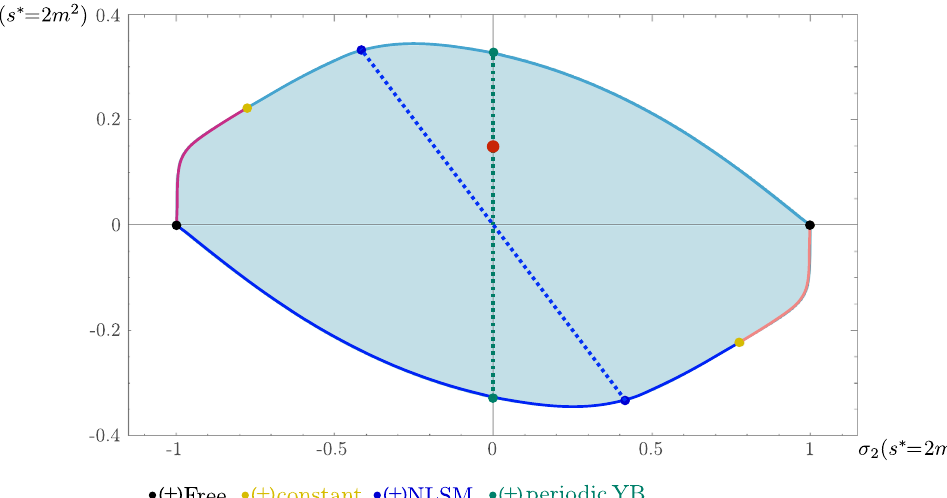
Figure 7: Allowed space of S-matrices in the plane  1 ( s ⇤ = 2) vs  2 ( s ⇤ = 2). The coloring at its Figure 10 . Allowed region in the ( (cid:27) (cid:3) ; (cid:27) (cid:3) ) plane for N = 7 (from (cid:12)gure 7 of [52]). The blue 2 1 boundary matches the convention in table 1. We have also marked the points corresponding to dashed line marks the section (5.31) ending at the integrable O( N ) sigma model (NLSM). The known integrable S-matrices and the constant solution in (7). green dashed line marks the section (5.32) ending at the periodic Yang-Baxter solution (pYB). The red dot marks the value of ( (cid:27) (cid:3) ; (cid:27) (cid:3) ) that minimizes the UV central charge. 2 1